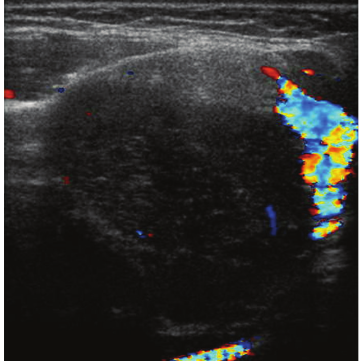
Figure 1: Ultrasound right neck mass.